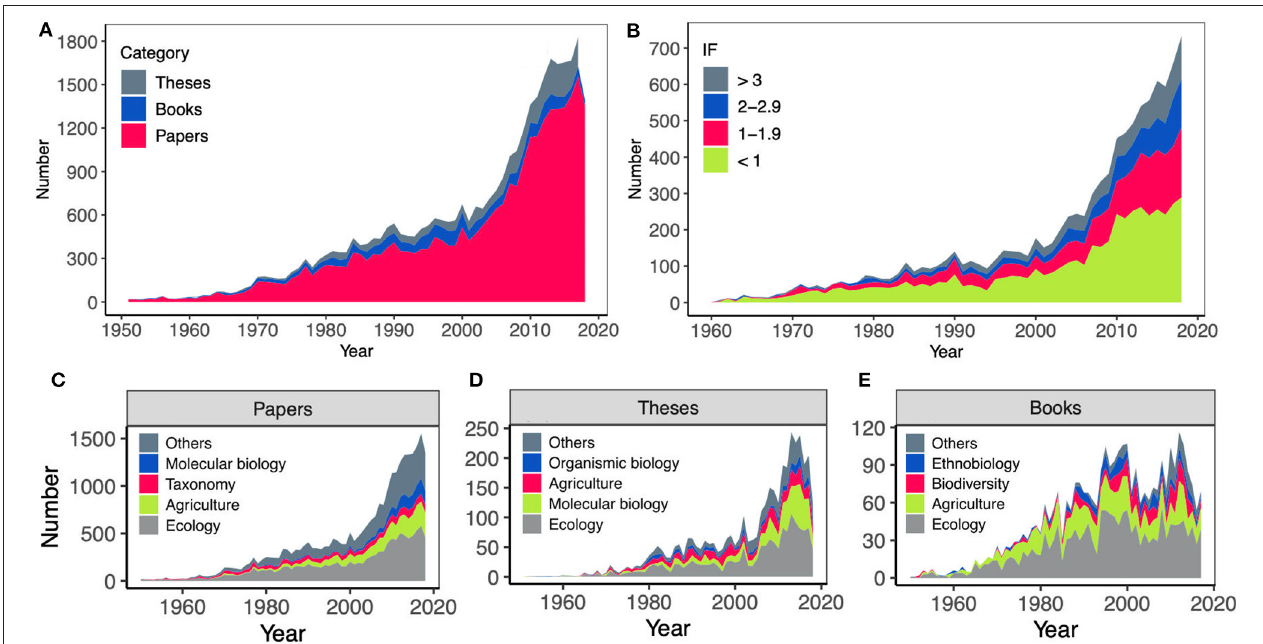
FIGURE 4 | Temporal trend of publications from 1950 to 2018. (A) Number of papers, theses, and books published annually. (B) Number of papers published in four impact-factor categories. (C–E) Number of journal articles, theses, and books published under major research disciplines.